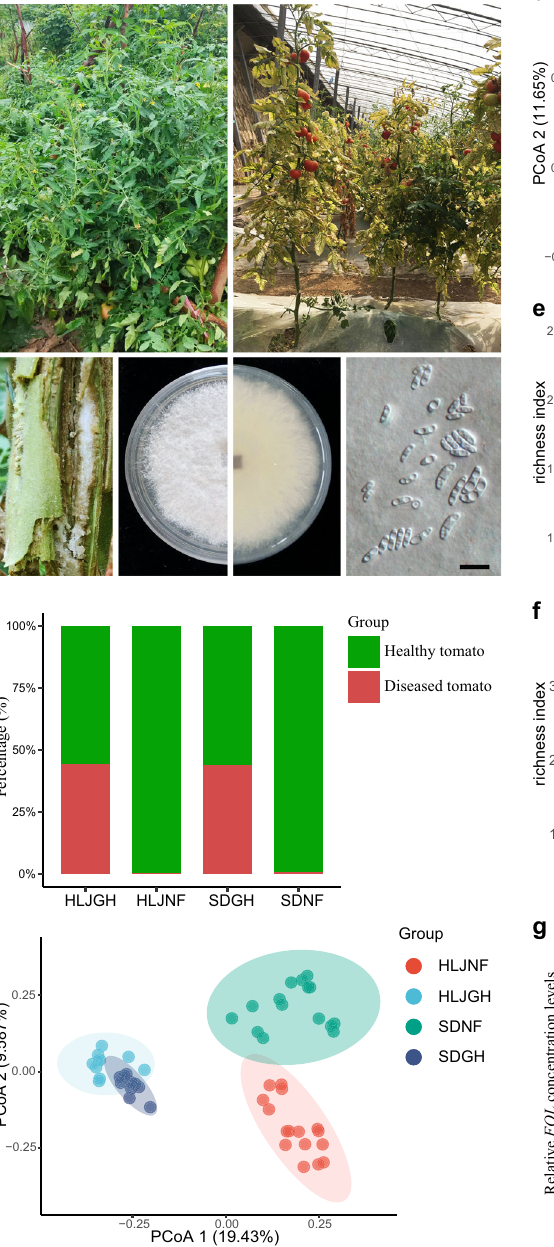
Fig. 1 | Imagesofnatural fi eld-grown (NF) and greenhouse-grown (GH)tomato plants,andmicrobialdiversityandcommunitycompositionatdifferentsites. a Top row: representative NF and GH tomato sampling sites. Different tomato plants were collected at each natural fi eld and greenhouse sites (left and right, accordingly) and 10 – 16 tomato plants were sampled as biological replicates for each site, respectively. Bottom row: isolation of F. oxysporum f. sp. lycopersici ( FOL ) from tomato (far left); representative FOL colony growing on PDA, photographed from above and from below (center left and center right, respectively); and representative FOL conidial morphology (far right) (black scale bar = 10 μ m). b FWD disease inci- denceratesindifferentplantgroups(HLJNF,HLJGH,SDNF,andSDGH). c Bray – Curtis dissimilarityanalysisof fungalcommunities.The NFrhizosphere fungalcommunities from both Shandong and Heilongjiang Provinces are separated from their respective GH communities along the two axes ( P <0.001, PERMANOVA by Adonis). Ellipses cover 80% of the data for each sampling site. d Bray – Curtis dissimilarity analysis of bacterial communities (principal coordinates PCo1 and PCo2). The NF rhizosphere microbiotafrombothShandongandHeilongjiangProvincesareseparatedfromtheir respective GH microbiota along the two axes ( P <0.001, PERMANOVA by Adonis).